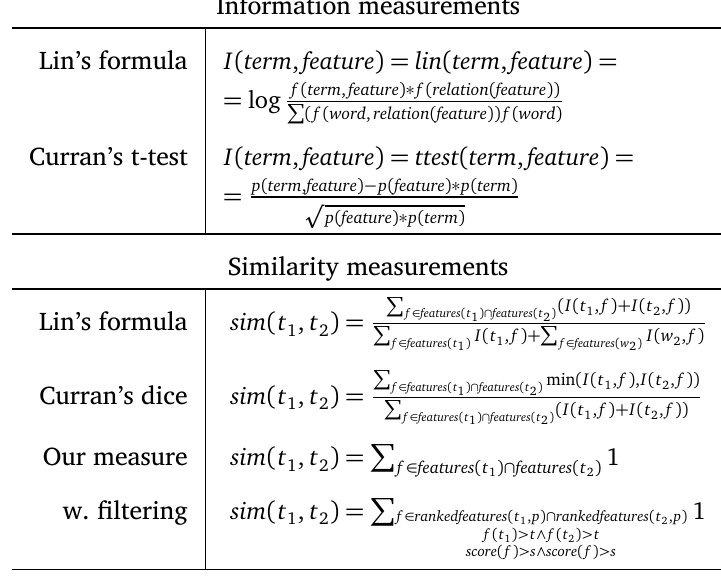
Table 1: Similarity measures used for calculating the distributional similarity between terms